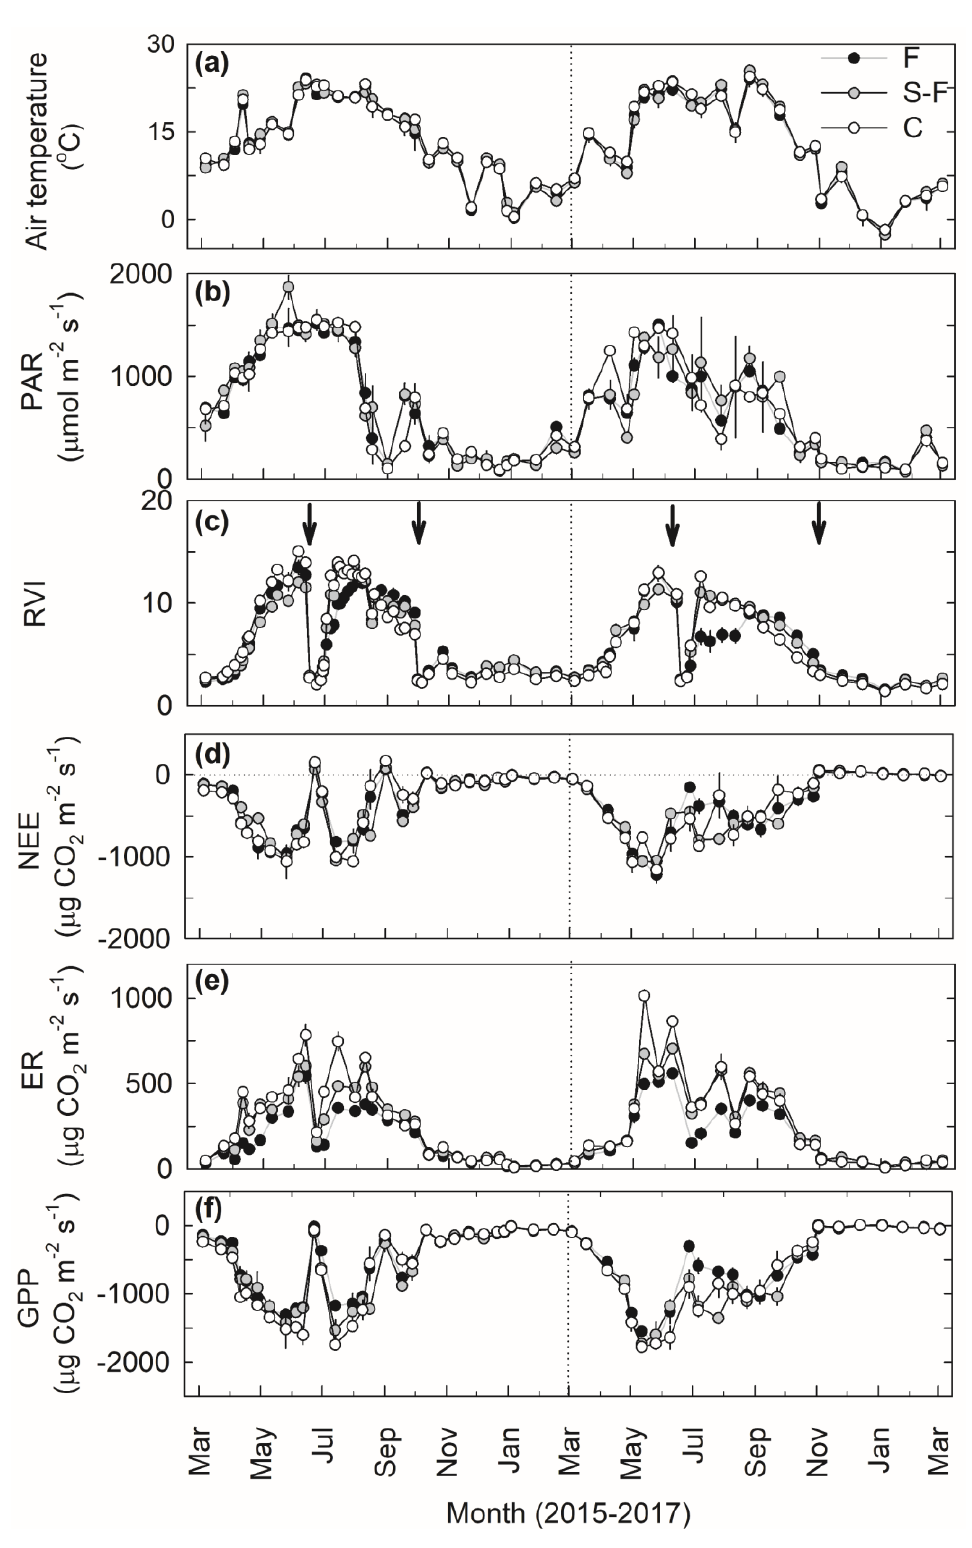
Figure 5. (a) Mean air temperature during flux measurements, (b) photosynthetically active radiation (PAR) inside fully transparent chamber at prevailing light conditions during flux measurements, (c) ratio vegetation index (RVI) as a proxy of green biomass, (d) mid-day net ecosystem exchange (NEE) at prevailing PAR, (e) mid-day ecosystem respiration (ER), and (f) gross primary production (GPP) calculated as GPP = NEE - ER. Data are shown for flooded (F), semi-flooded (S-F) and control (C) plots. Error bars represent the spatial variation (standard error, n = 4 for F plots and n = 2 for S-F and C plots). Arrows indicate harvest events. The dotted vertical line demarks the two study